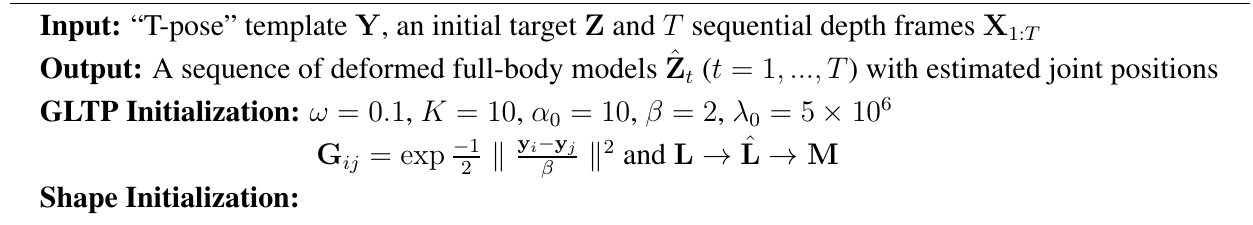
Algorithm 1 The Pseudo-Code of the Proposed Pose Estimation